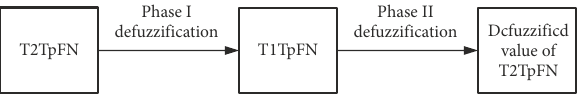
Figure 1. Defuzzification process of